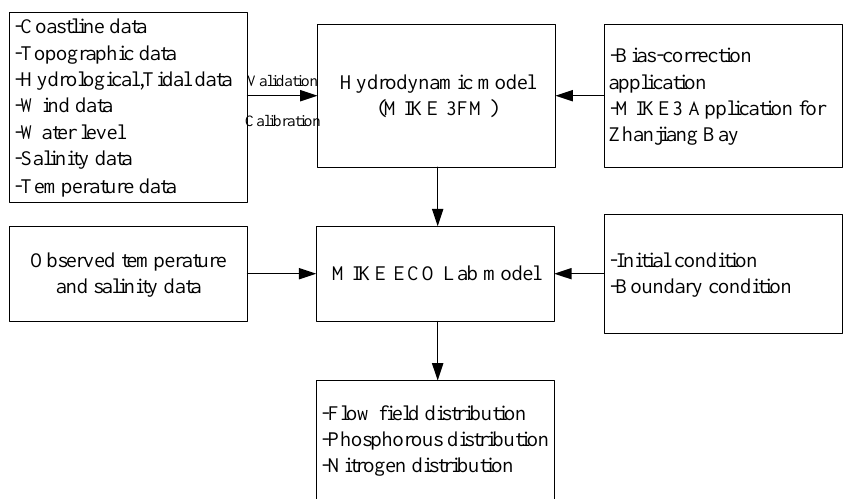
Figure 3. Schematic of the modeling framework for this study.